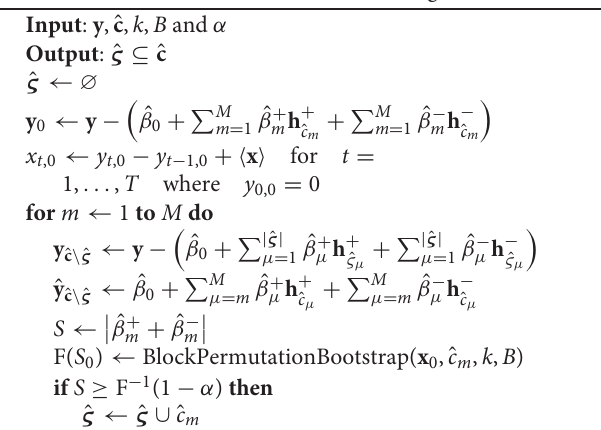
Algorithm 3: Block-permutation bootstrap procedure for PARCS, given block size k . The H 0 -conform time series x 0 is estimated before entering the loop. The loop iterates over the rank-ordered CPs to test for each CP’s